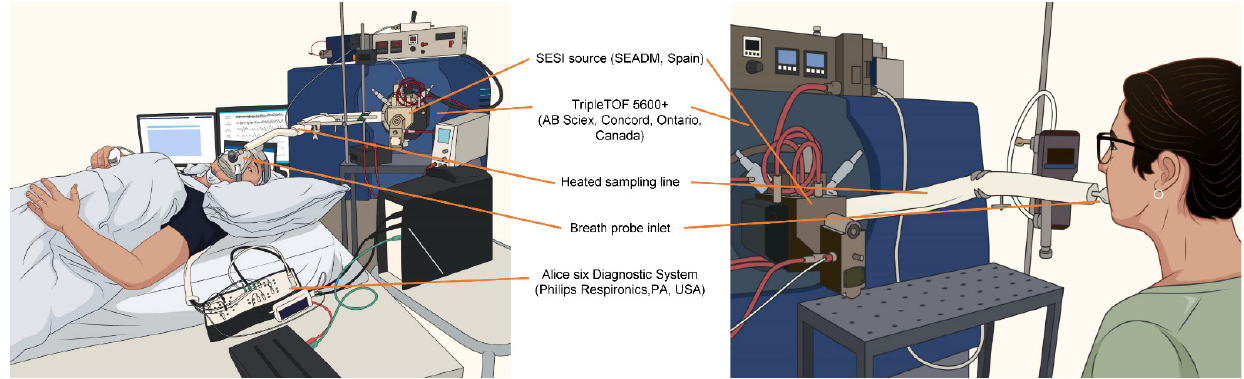
Figure 4. Setup of longitudinal whole ‐ night measurements in healthy participants ( left ) and cross ‐ sectional breath measurement during the day in OSA ‐ suspected patients ( right ).